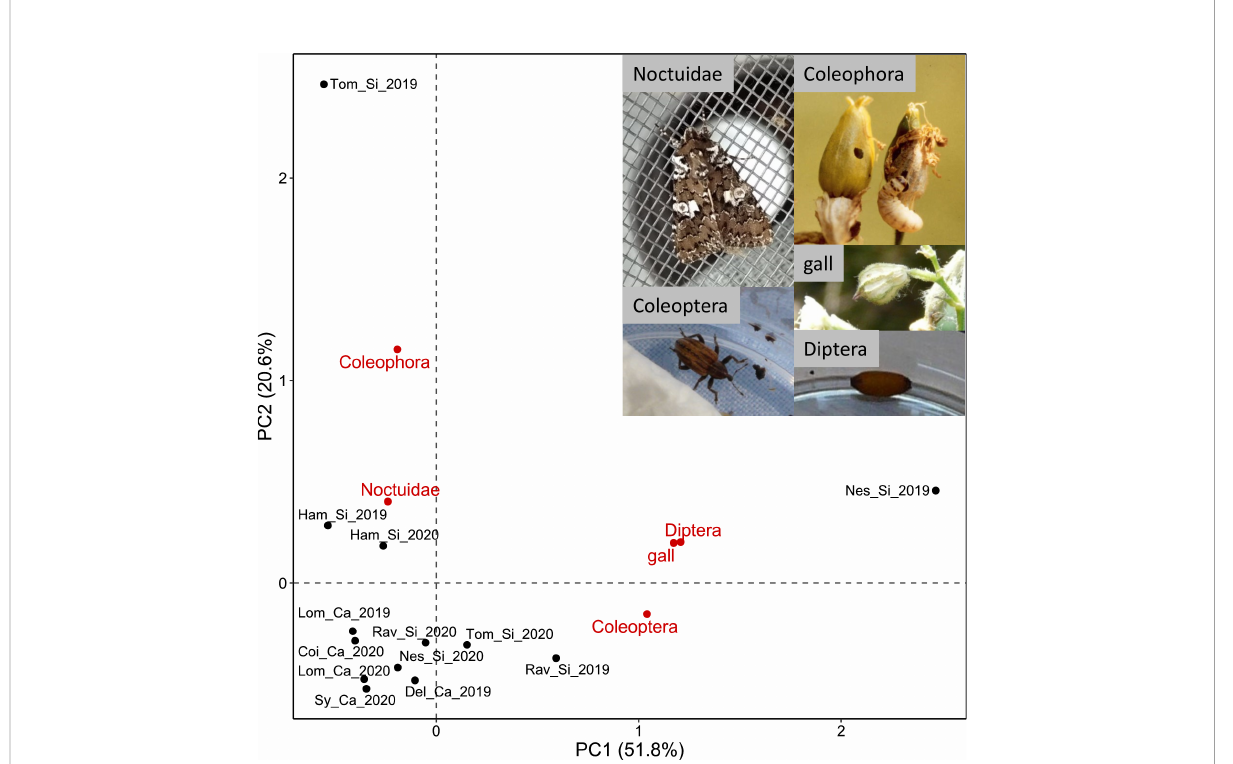
FIGURE 3 Principal Component Analysis on the number of seed predators of Silene nutans found in eight calcicolous (Ca) and silicicolous (Si) populations (black dots) from southern Belgium in 2019 (_19) and 2020 (_20), grouped in fi ve taxonomic groups (Noctuidae, Coleophora , Coleoptera (Curculionidae), Diptera ( Delia ) and gall; see Table 2) and shown as centroids (red